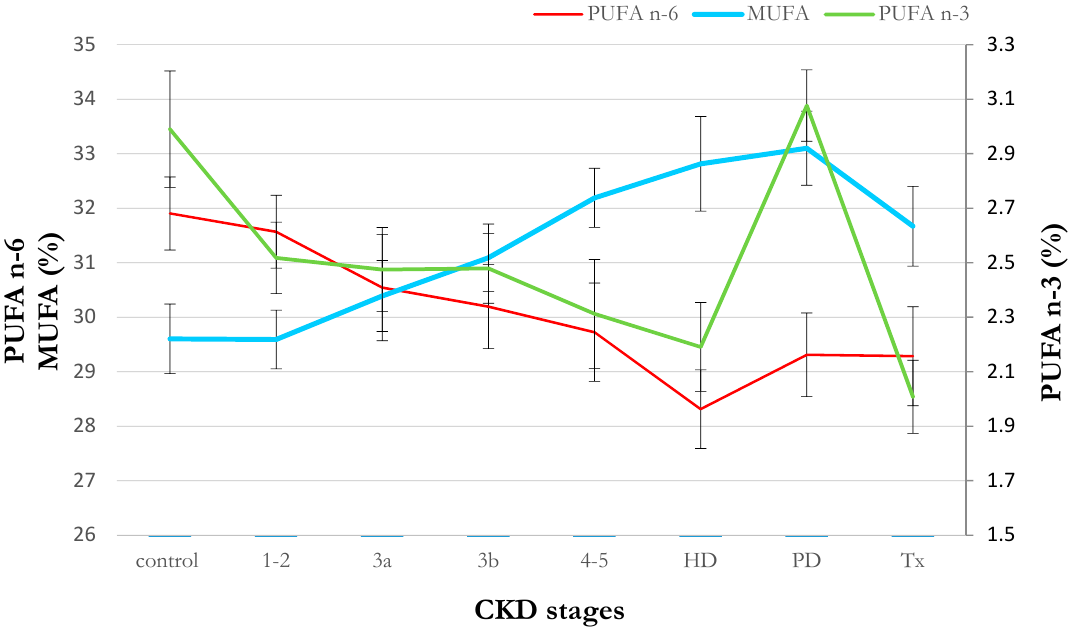
Figure 1. Serum proportion of n-3, n-6 polyunsaturated fatty acids (PUFA) and monounsaturated fatty acids (MUFA) in chronic kidney disease (CKD) patients with consecutive stages of disease. Data are shown as mean ± SEM. * p < 0.01; # p < 0.05 comparing to healthy control group. CKD—chronic